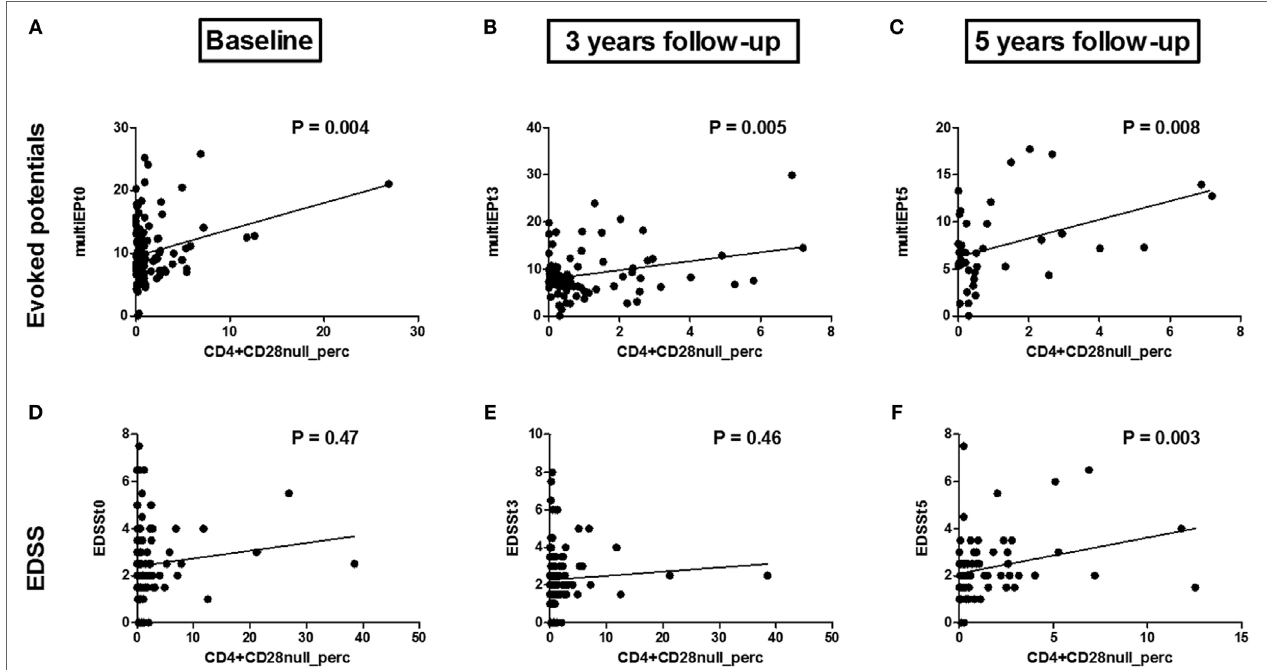
FiGUre 1 | Associations between the CD4 + CD28null T cell percentage and multi evoked potential (multiEP) and expanded disability status scale (EDSS): Association between the CD4 + CD28null T cell percentage at baseline [ (a) , t 0, N = 109], 3 years [ (b) , t 3, N = 82], and 5 years [ (c) , t 5, N = 39] with multimodal evoked potentials (multiEP). Association between the CD4 + CD28null T cell percentage and EDSS at baseline [ (D) , t 0, N = 121], EDSS 3 years post sampling [ (e) , t 3, N = 122], and 5 years post sampling [ (F) , t 5, N = 110]. P -values are corrected for disease duration and gender.